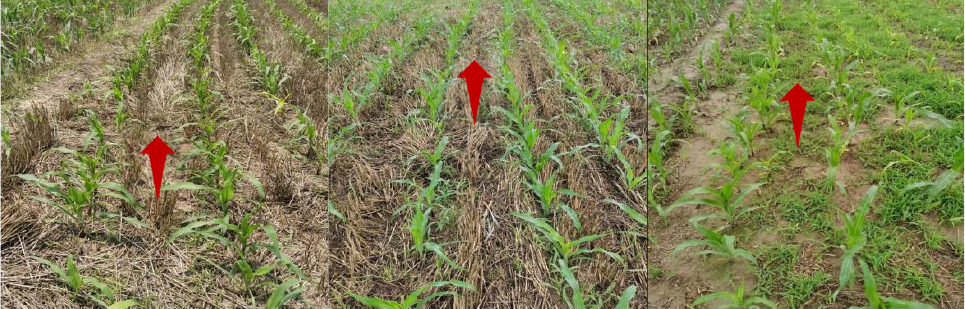
Figure 7. Rows of corn with varying degrees of curvature. The left image is a curved corn row in bright light. The middle image is a curved corn row in normal light. The final image is a curved corn row on a cloudy